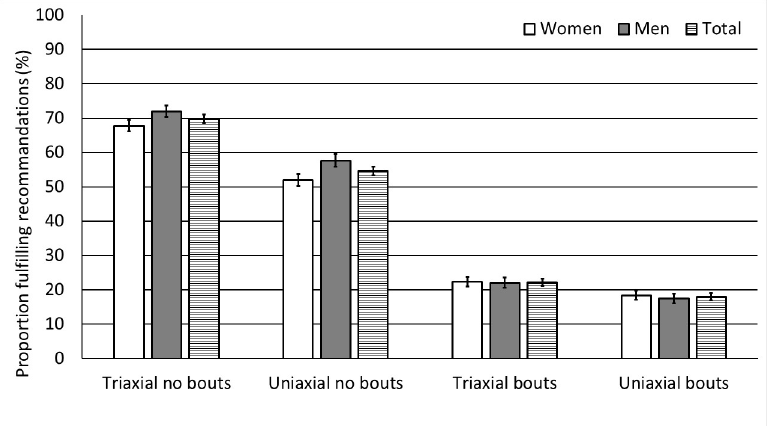
Fig 1. The proportion of women (n = 3172) and men (n = 2746) separately, and in total (n = 5918), fulfilling the WHO´s recommendations for physical activity of 150 minutes of MVPA per week, in both accumulated non- bouted and bouted MVPA and from triaxial and uniaxial data. Data is shown as percentage and error bars are 95%